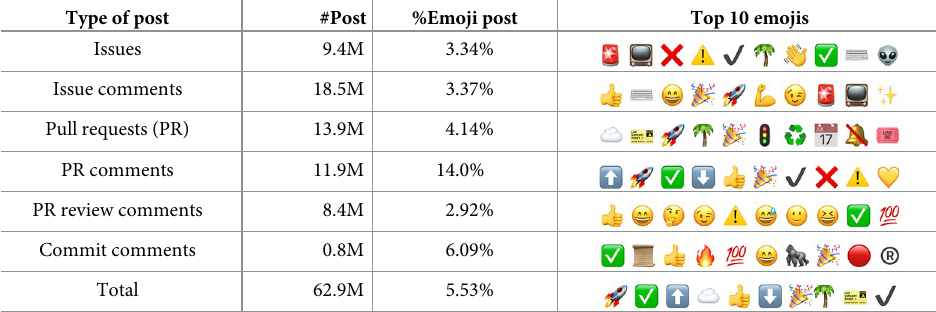
Table 1. Emoji usage on GitHub by post type. Over 5% of posts on GitHub contain at least one emoji. Pull request comments and commit comments have higher proportions of emoji